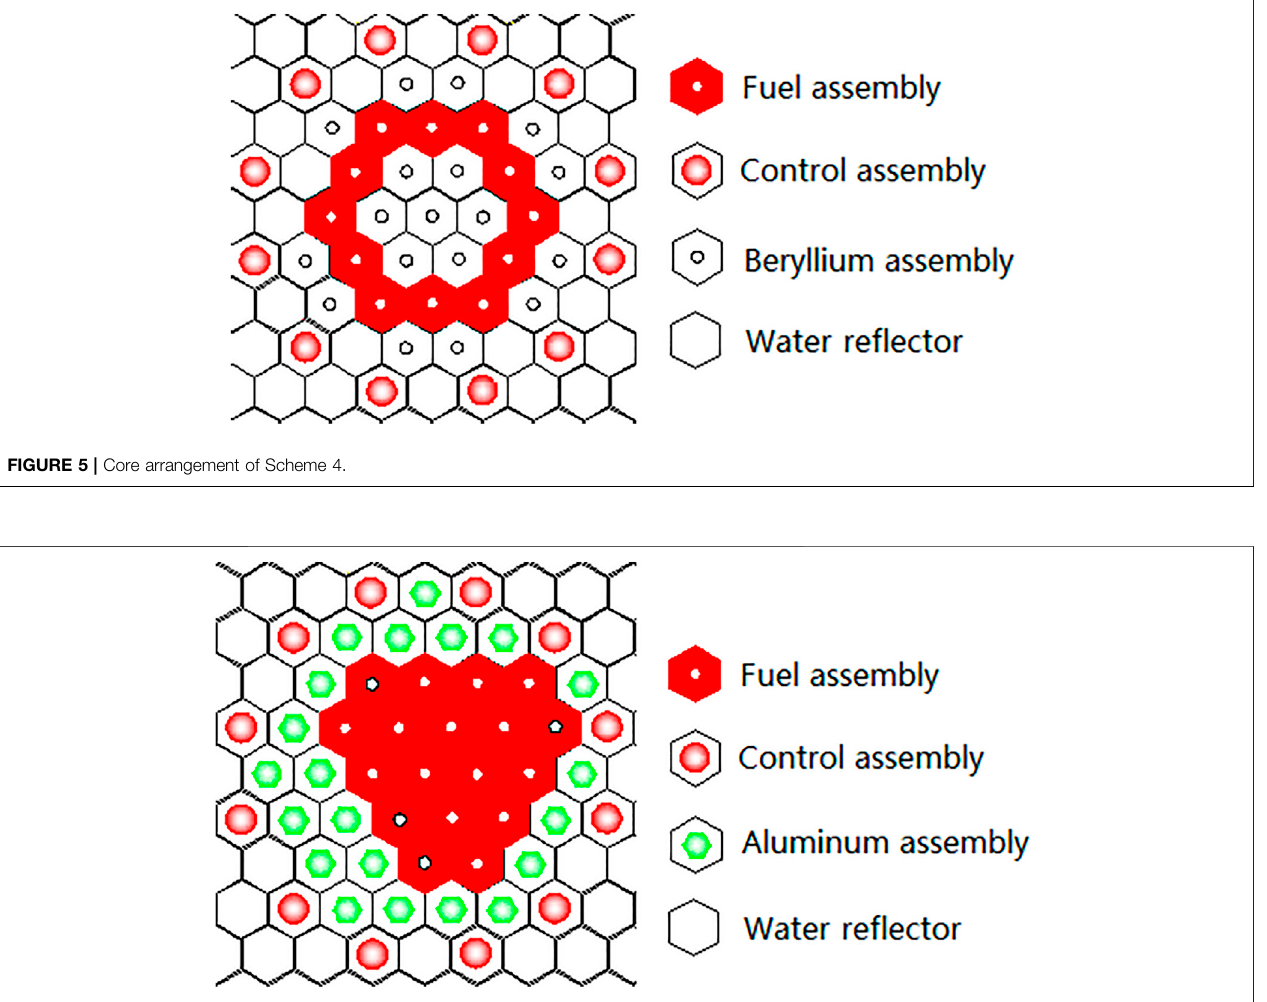
FIGURE 6 | Core arrangement of Scheme